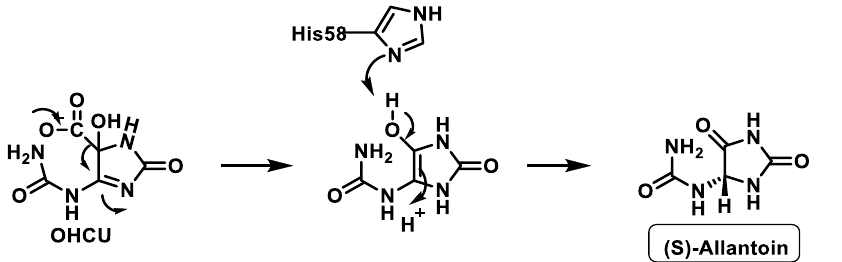
Figure 10. Schematic representation of the ureide pathway.